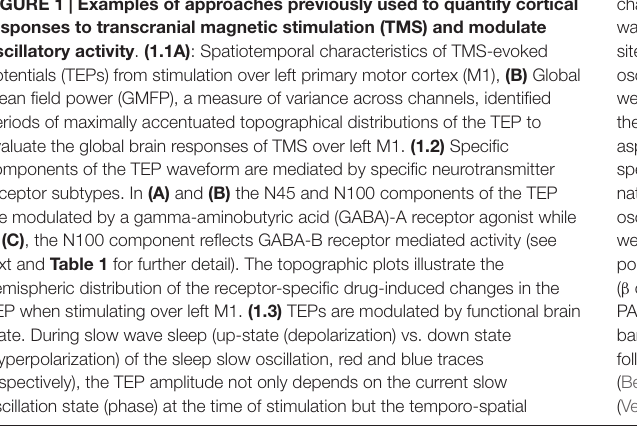
FIGURE 1 | Examples of approaches previously used to quantify cortical responses to transcranial magnetic stimulation (TMS) and modulate oscillatory activity . (1.1A) : Spatiotemporal characteristics of TMS-evoked potentials (TEPs) from stimulation over left primary motor cortex (M1), (B) Global mean field power (GMFP), a measure of variance across channels, identified periods of maximally accentuated topographical distributions of the TEP to evaluate the global brain responses of TMS over left M1. (1.2) Specific components of the TEP waveform are mediated by specific neurotransmitter receptor subtypes. In (A) and (B) the N45 and N100 components of the TEP are modulated by a gamma-aminobutyric acid (GABA)-A receptor agonist while in (C) , the N100 component reflects GABA-B receptor mediated activity (see text and Table 1 for further detail). The topographic plots illustrate the hemispheric distribution of the receptor-specific drug-induced changes in the TEP when stimulating over left M1. (1.3) TEPs are modulated by functional brain state. During slow wave sleep (up-state (depolarization) vs. down state (hyperpolarization) of the sleep slow oscillation, red and blue traces respectively), the TEP amplitude not only depends on the current slow oscillation state (phase) at the time of stimulation but the temporo-spatial